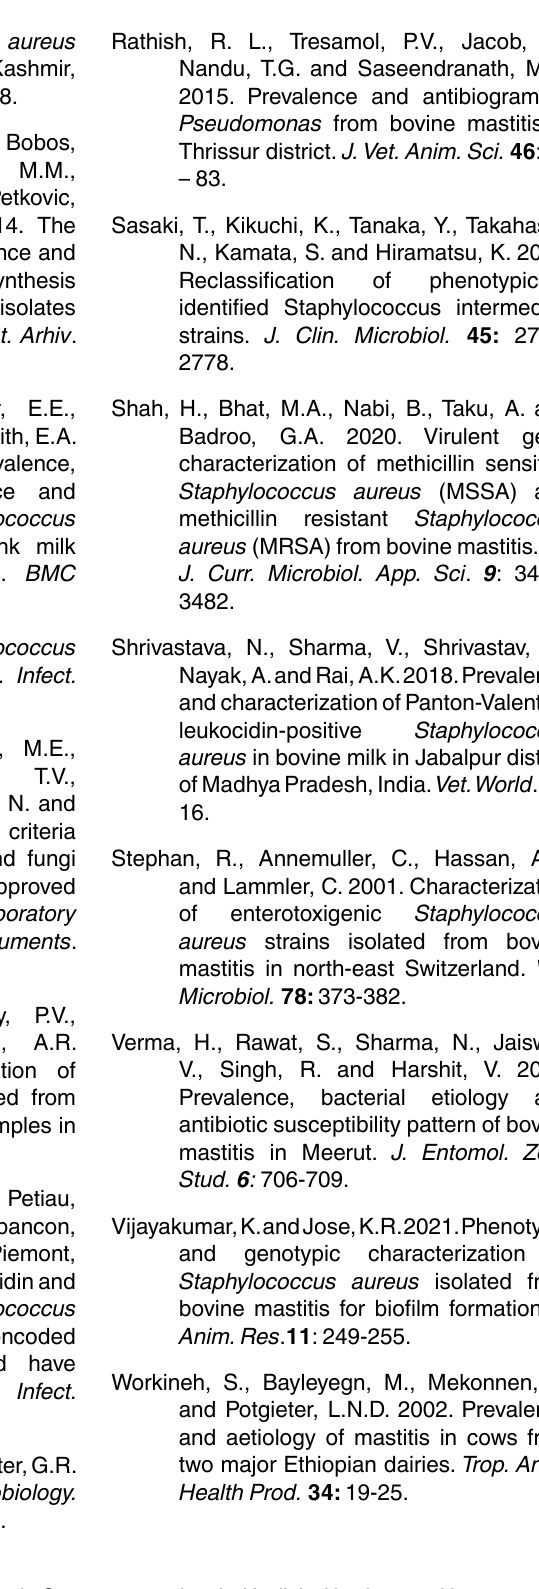
284 Molecular characterisation of virulence genes in S. aureus associated with clinical bovine mastitis